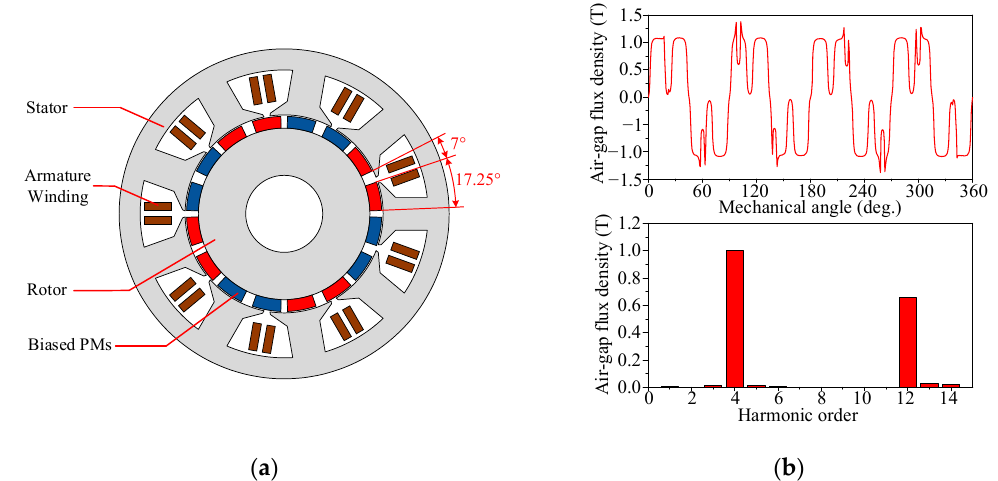
Figure 3. Dual-harmonic PC motor with split PMs. ( a ) Motor structure. ( b ) Air-gap flux density waveform and spectra.